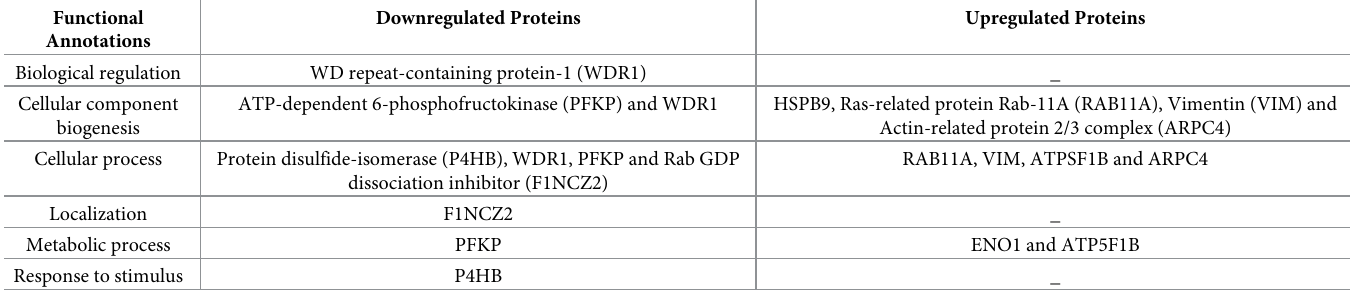
Table 6. Go-annotated proteins associated with different biological processes after sodium butyrate treatment in HTC cells infected with S .